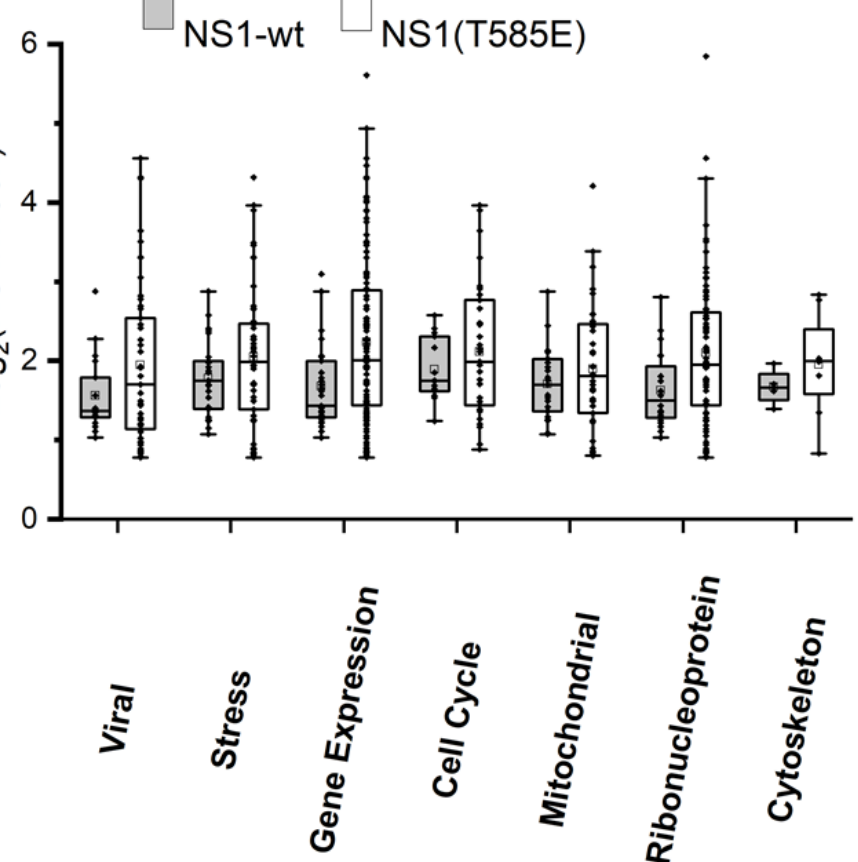
Figure 5. Proteomics-based identification of proteins within close proximity to NS1-wt and NS1-T585E. Hep3B cells were transfected with NS1-wt-BioID2 or NS1-T585E-BioID2 or BioID2 only. Proteins in close proximity and therefore biotinylated by BioID2 were pulled down using streptavidin beads. Proteins identified by mass spectrometry with a significantly higher abundance compared to BioID2-only control are grouped with respect to the indicated biological processes or cellular components. Box plot representation of median, 1st and 3rd quartile, whiskers as quartiles plus 1.5 times the interquartile range (IRQ), and outliers.